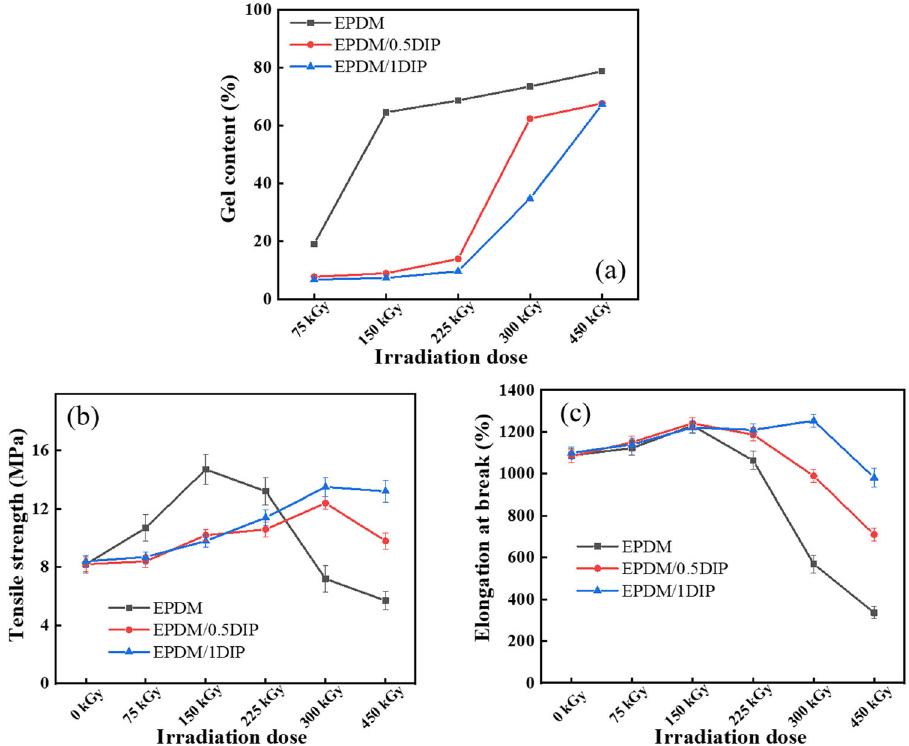
Fig. 3 Gel fractions and mechanical properties of the EPDM and EPDM/DIP blends at different γ -irradiation doses. a Gel fractions of the EPDM and EPDM/DIP blends, b tensile strength of the EPDM and EPDM/DIP blends, c elongation at break of the EPDM and EPDM/DIP blends (Error bars stand for the standard deviations from at least fi ve independent